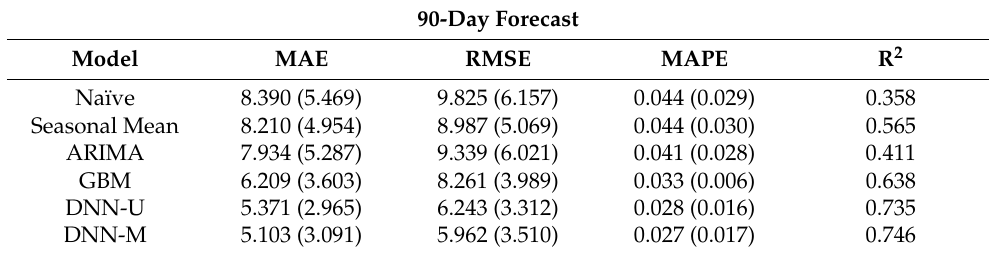
Table 7. Estimates for MAE, RMSE, MAPE, and R 2 calculated using TSCV for a 90-day